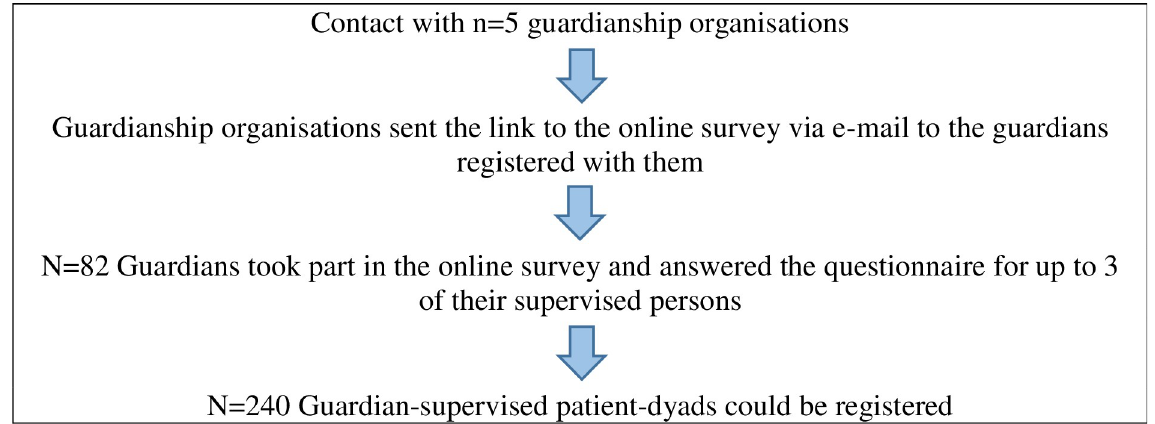
Fig 1. Sampling of guardian-supervised